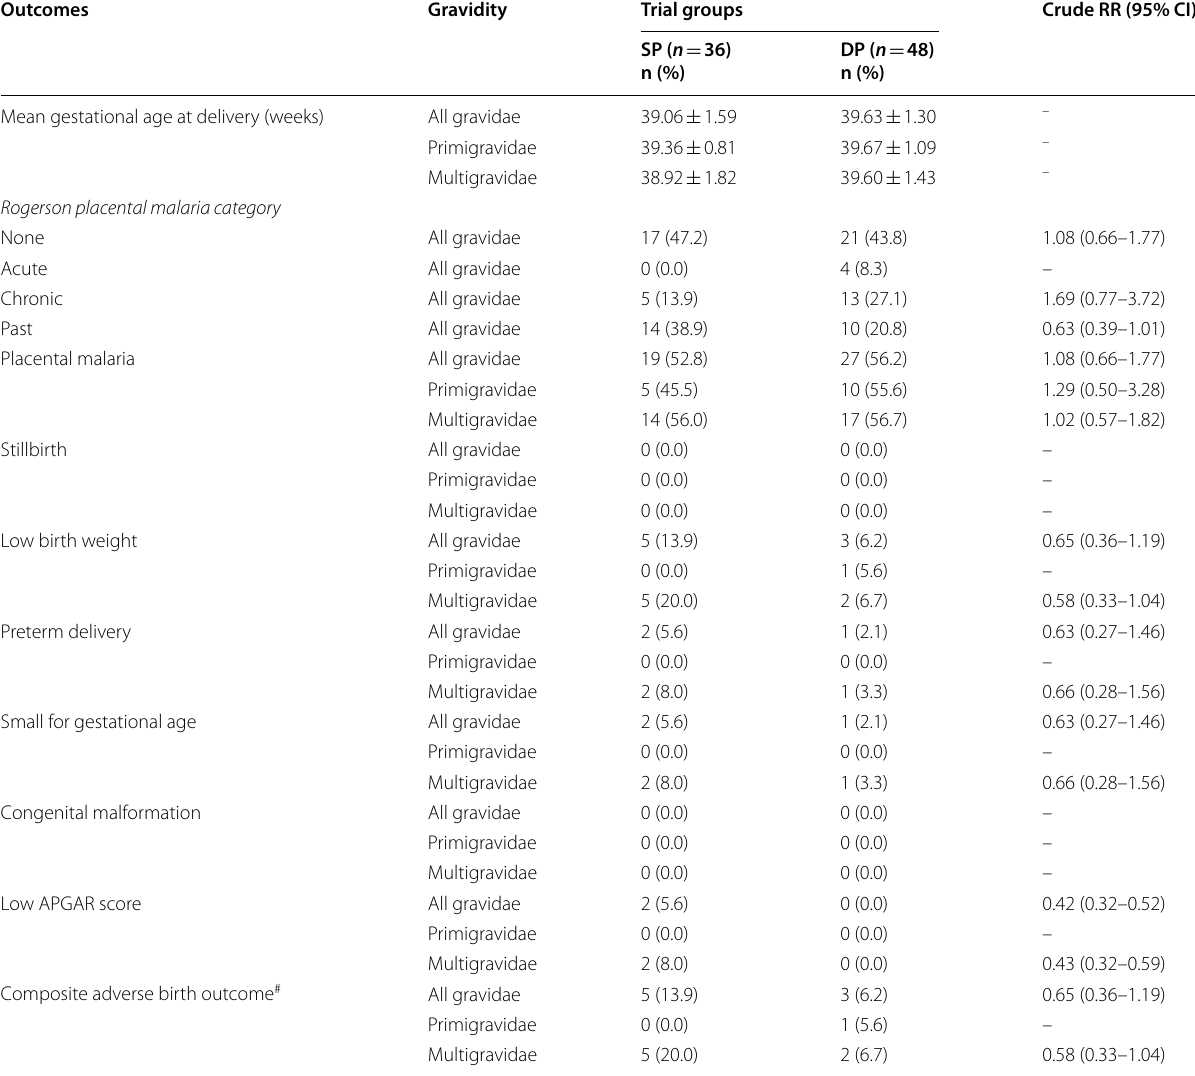
Table 3 Per protocol analysis results of the primary and secondary outcomes ( N